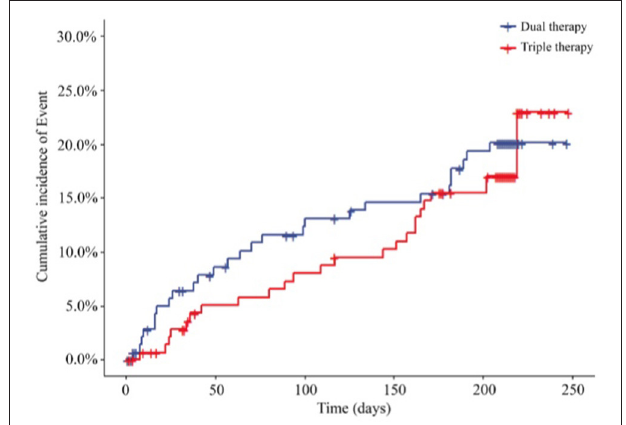
FIGURE 4 | Incidence of cardiovascular event outcomes of the 2 groups (HR, 0.845; 95% CI, 0.488 to 1.465; P = 0.5484). HR, hazard ratio. Dual therapy: ticagrelor therapy group; triple therapy: clopidogrel plus aspirin